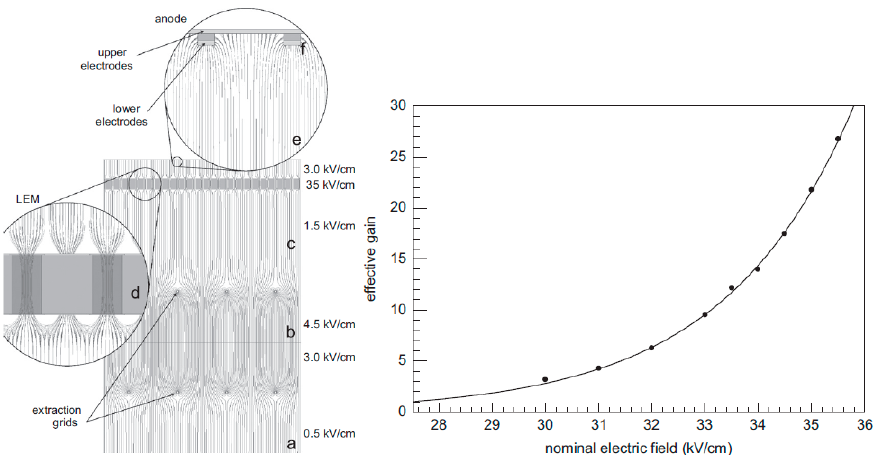
Figure 20. Left: electric field configuration in two-phase detector with THGEM (LEM) 2D readout [4,73]. Right: “Effective” gain characteristic for single-THGEM multiplier charge 2D readout in two-phase Ar detector, of an active area of 10 × 10 cm 2 [4,73], as a function of the nominal electric field in THGEM. The maximum gain was limited by discharges. The “effective” gain value should be multiplied by about a factor of 3, to be normalized to the gain definition of the present review (see details in [4]).